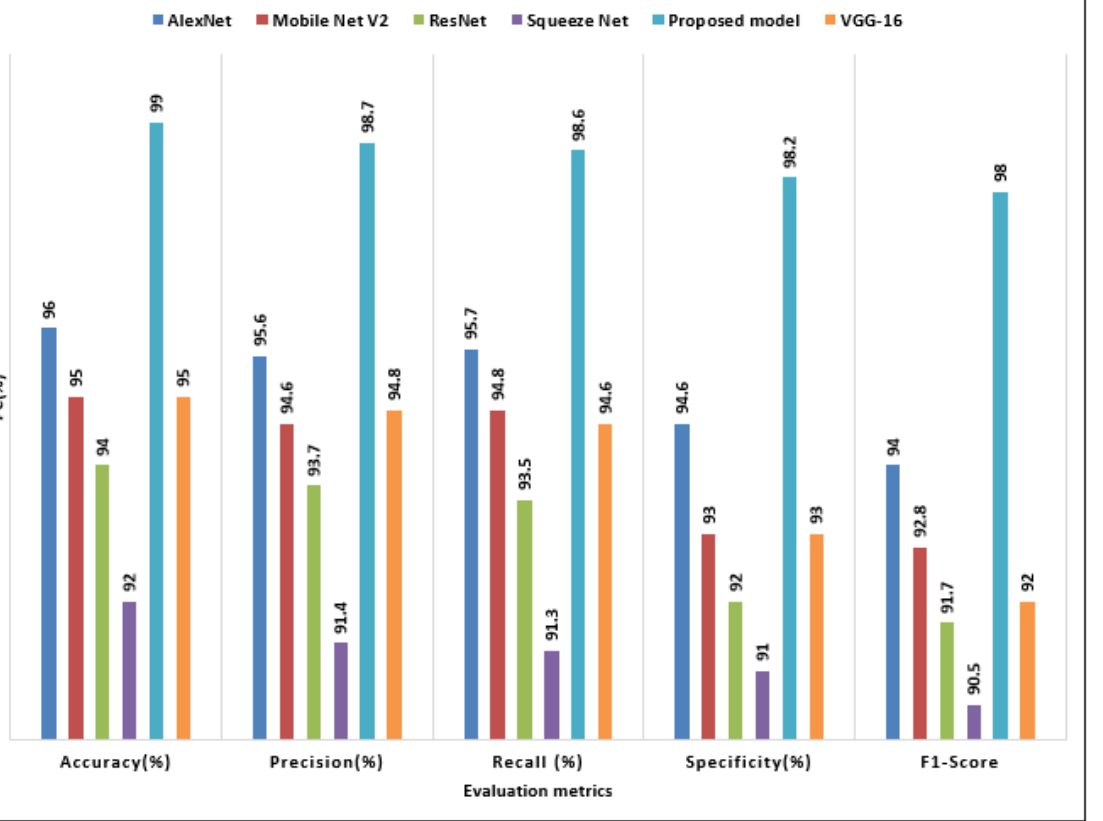
Figure 9. The performance indicator (Acc, Recall, Pres,and F1-Score) of the proposed model with other TL model of BTs Classification. other TL model of BTs